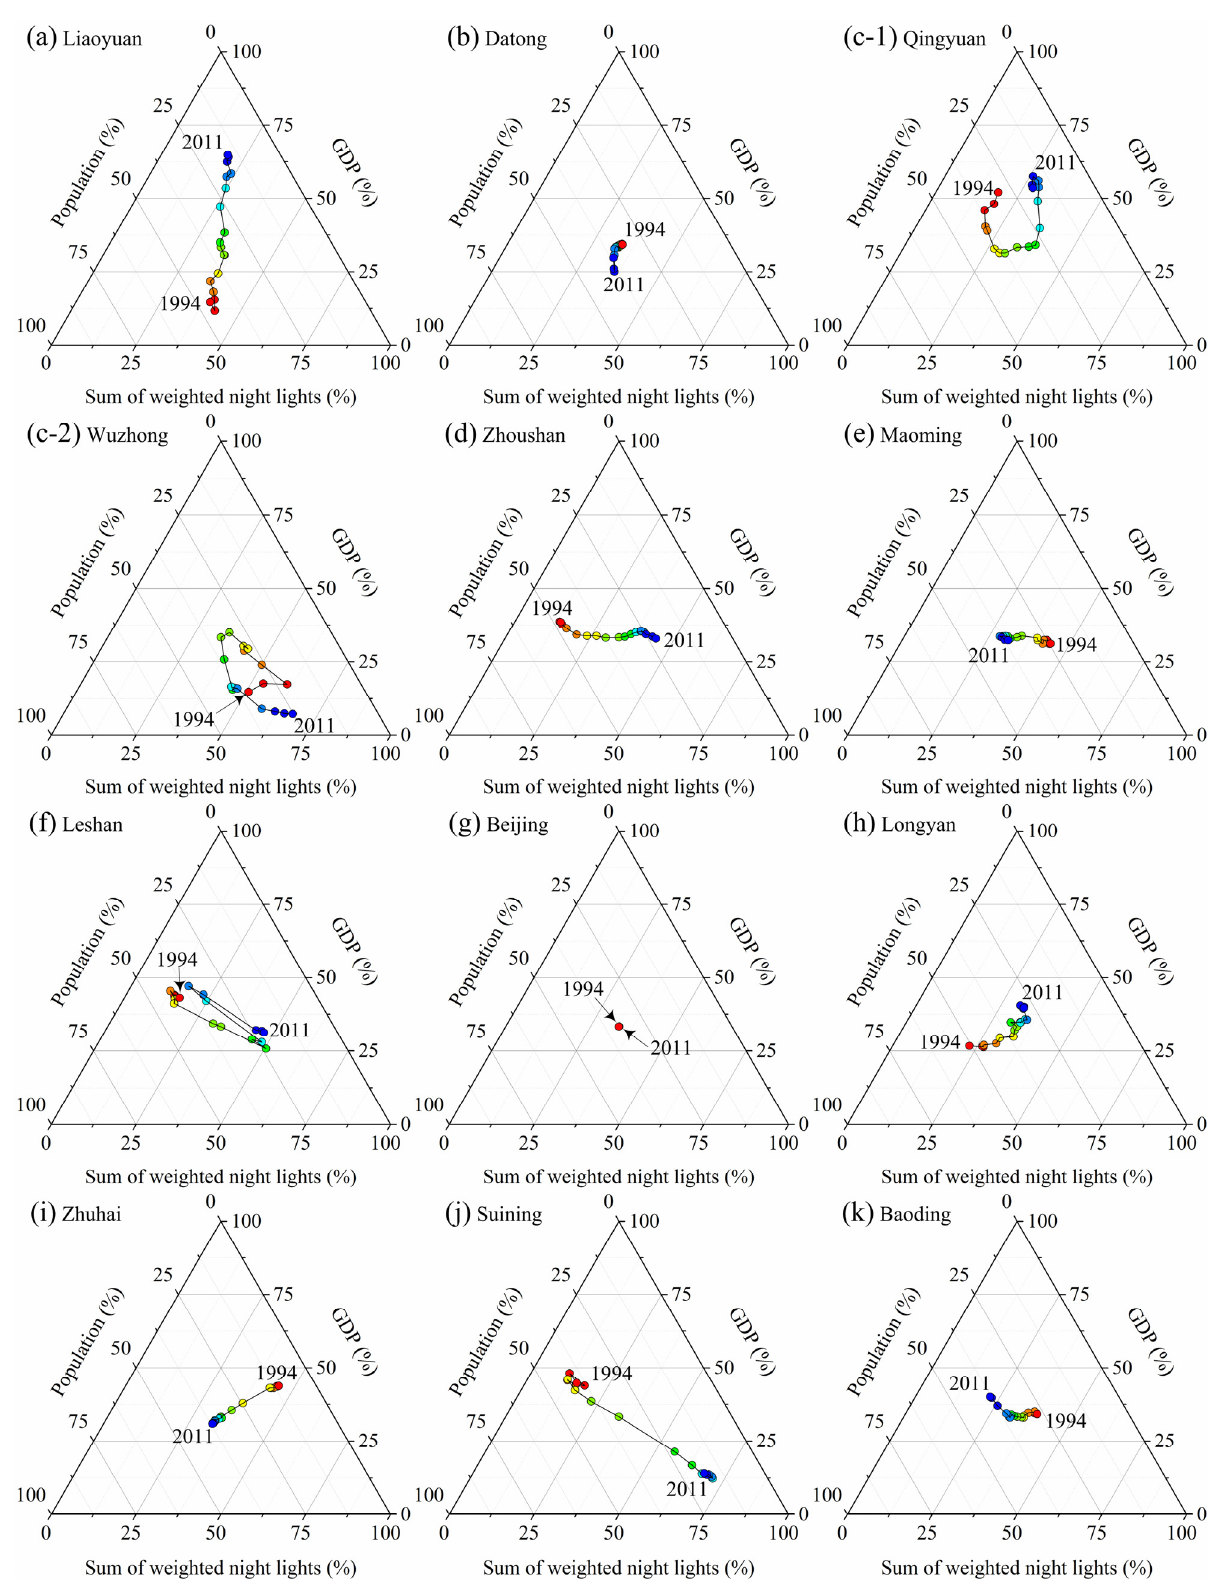
Figure 8. Eleven categories of different urbanization patterns: bottom to top ( a ), top to bottom ( b ), circle or half circle ( c-1 , c-2 ), left to right ( d ), right to left ( e ), reciprocate ( f ), central ( g ), left-bottom to right top ( h ), right-top to left-bottom ( i ), left-top to right-bottom ( j ) and right-bottom to right-top ( k ) of China’s